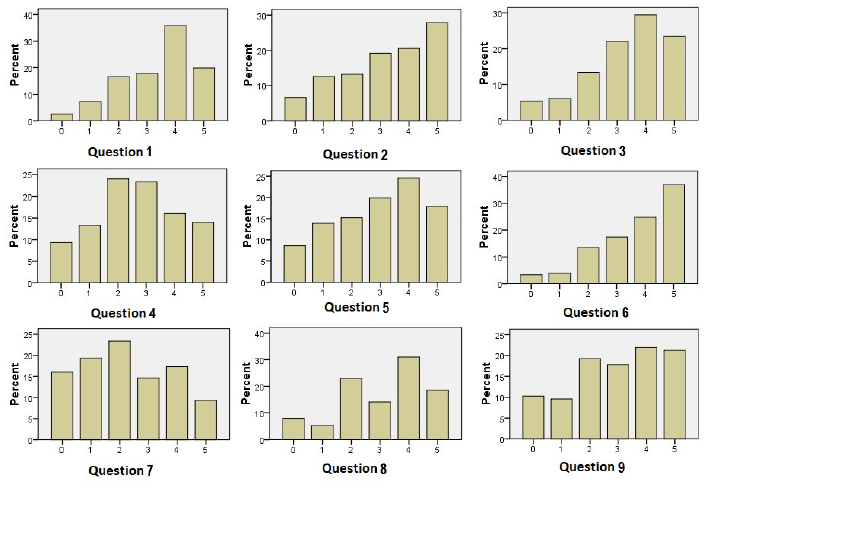
Figure 1: Question Category: